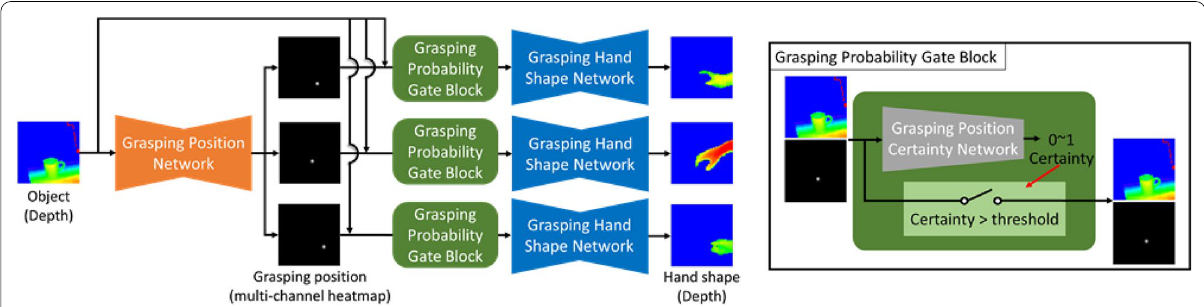
Fig. 1 The recalling flow of the multiple grasping